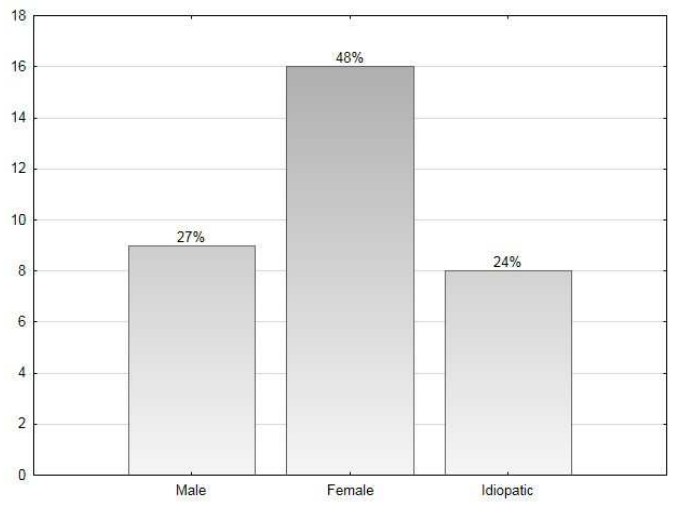
Figure 1. Causes of